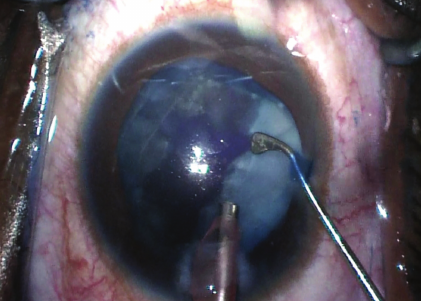
Figure 2: Trypan blue dye is noted on the posterior capsule during phacoemulsification.